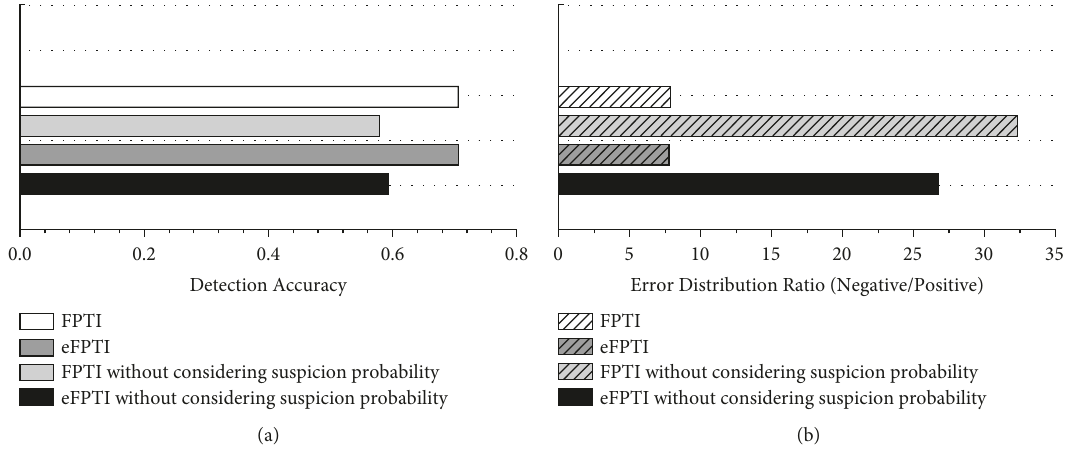
Figure 12: The effects of suspicion probability in the proposed models on (a) the detection accuracy, and (b) the error distribution. (a) Results of detection accuracy. (b) Results of error distribution ratio.